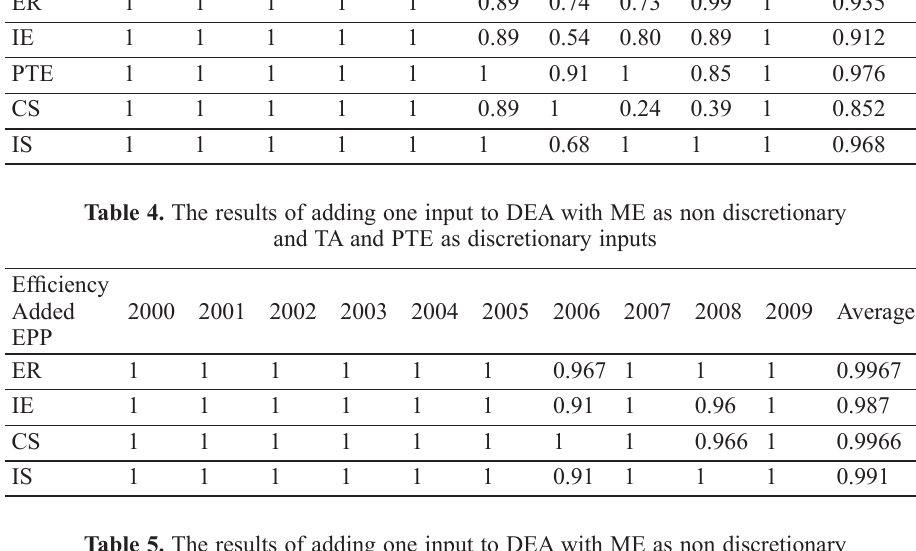
Table 5. The results of adding one input to DEA with ME as non discretionary and TA, PTE and ER as discretionary